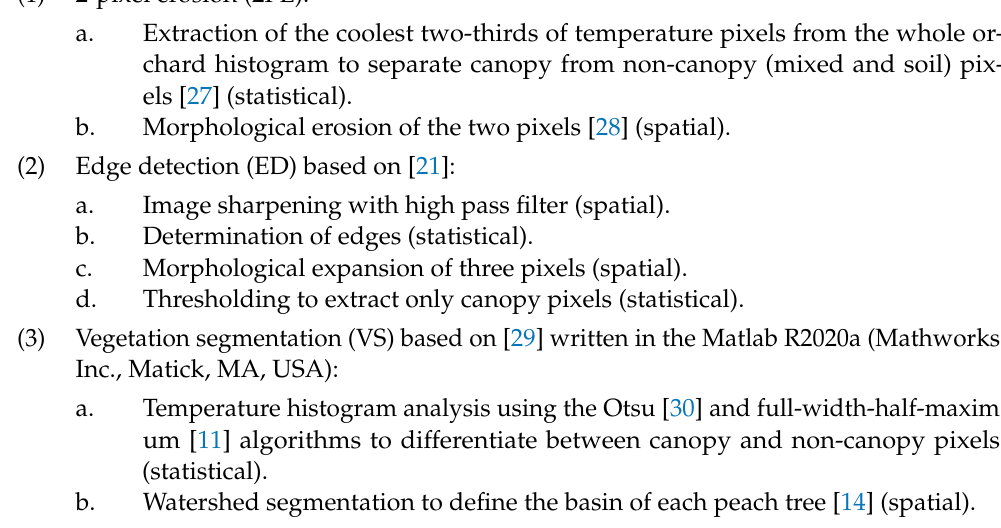
Figure 2. Data acquisition and analysis of orchard canopy extraction accuracy, canopy temperature, and orchard water status using the 2-pixel erosion (2PE), edge detection (ED), vegetation segmen- tation (VS), and RGB binary masking (RGB-BM) canopy extraction methods (green boxes). Canopy temperature per management cell (MC) was calculated using the average of 100% of canopy pixels (T100%) (orange boxes) and the average of the coolest 33% of canopy pixels (T33%) (blue boxes). Orchard water status was estimated using the crop water stress index (CWSI) and the estimated